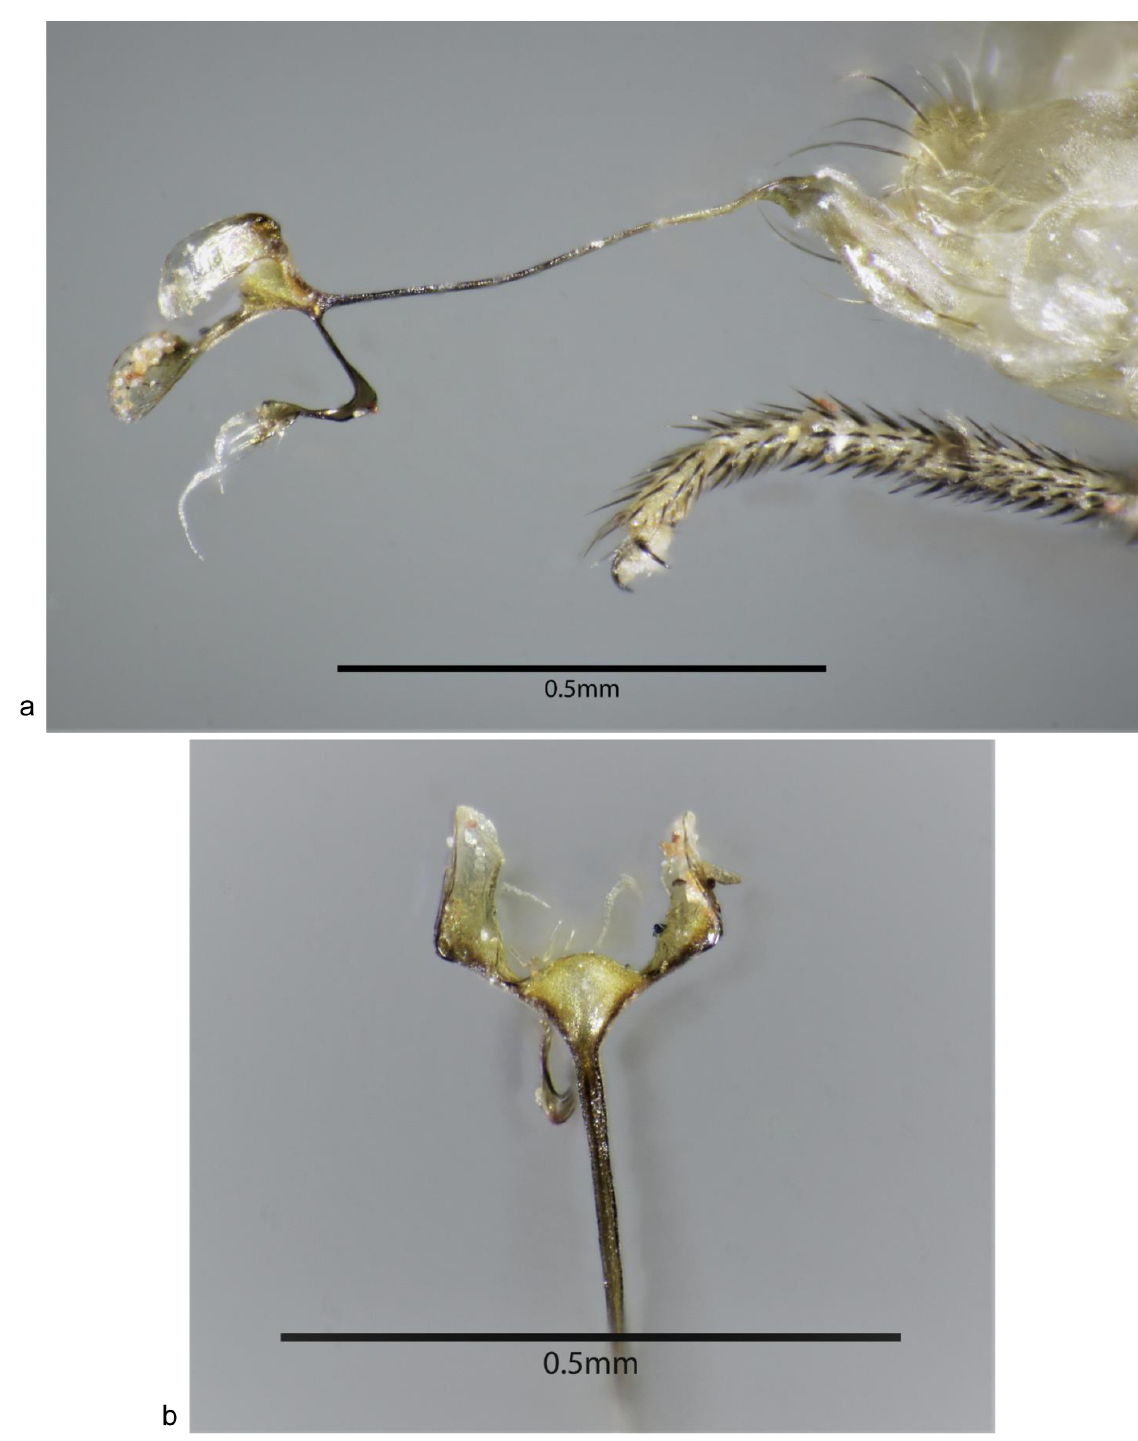
Fig. 7. Atherigona zongoi sp. nov., paratype, ♂ (NMWC). a . Trifoliate process, lateral oblique view. b . Same, ventral